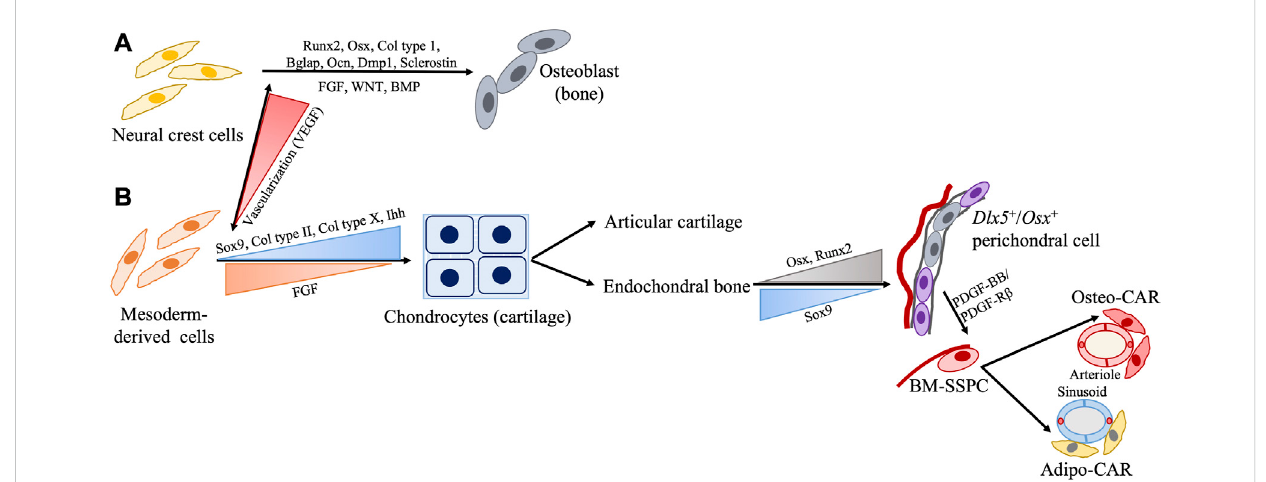
FIGURE 2 SchematicrepresentationofSSPCregulationduringdevelopmentfromembryoniccellorigin (A) neuralcrestcells(NCC)and (B) mesoderm-derived cells (MDD). Generally, bones NCC form via intramembranous ossi fi cation while bones from the MDD form via endochondral ossi fi cation with few interesting exceptionssuchasNCC-derivedclavicleforming via endochondralandMDD-derivedparietalboneforming via intramembranousprocesses. Presence or absence of adequate vascularization may play a role in